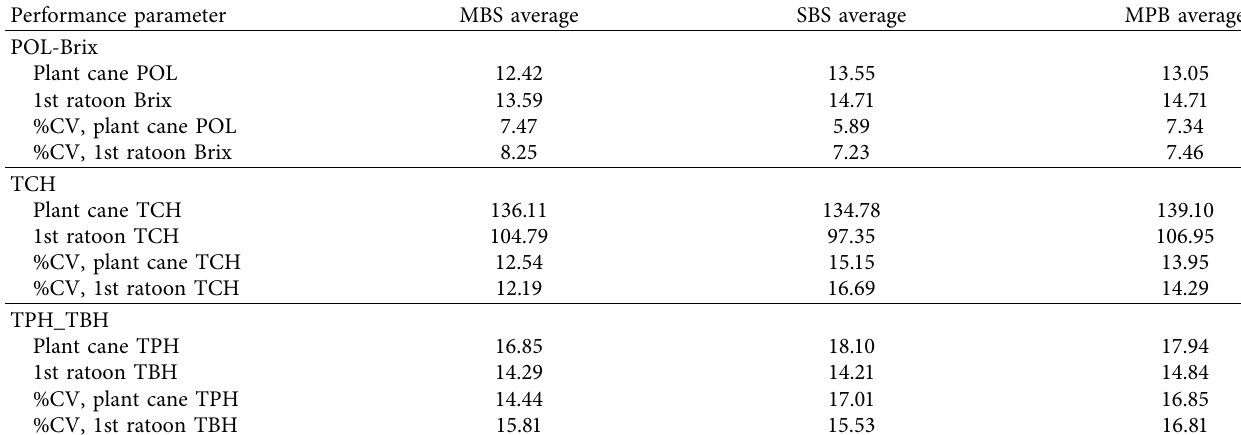
Table 2: Average performance parameters and coefficients of variation (CV) in trials with 3 types of planting materials, 29 genotypes, and 3 blocks (replicates) per planting material.